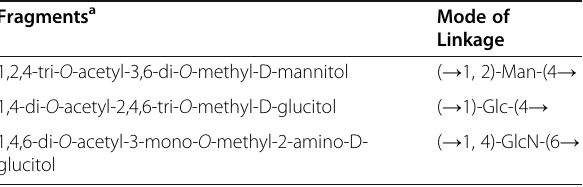
Table 2 Results of the analysis of GC-MS Fragments a Mode of